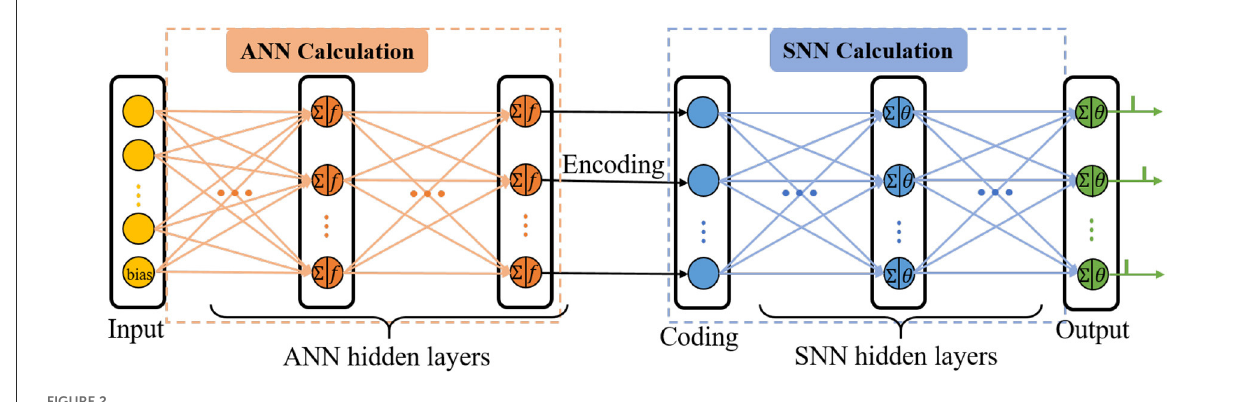
FIGURE2 The topology structure of the